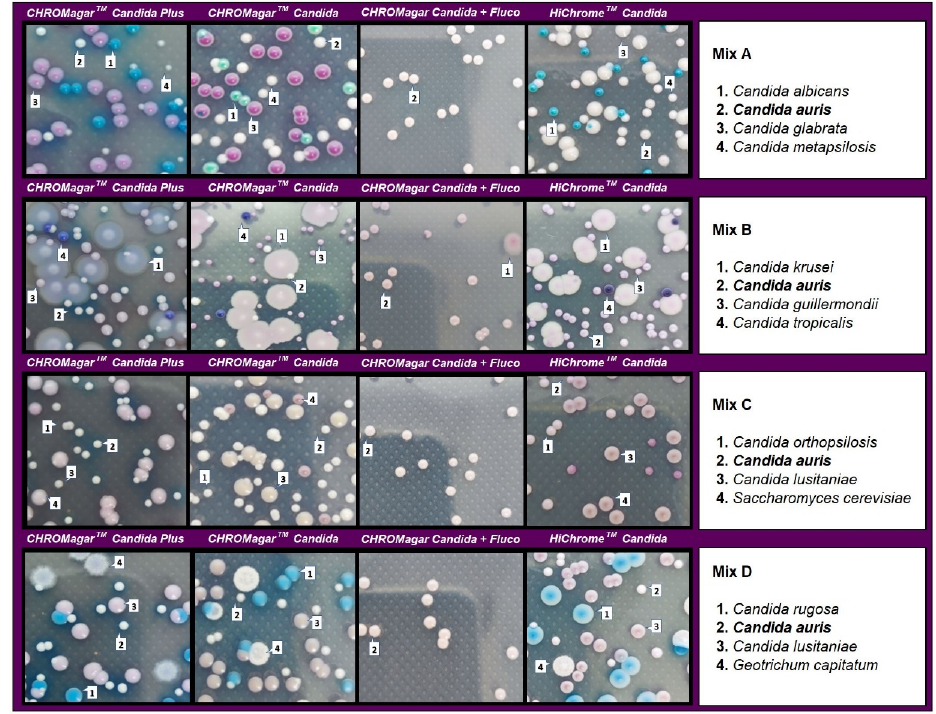
Figure 4. Appearance of Candida species and other yeast species colonies from mixed cultures on CHROMagar™ Candida Plus, CHROMagar™ Candida, CHROMagar™ Candida plus fluconazole, and HiCrome TM Candida after 48 h incubation at 35 °C.